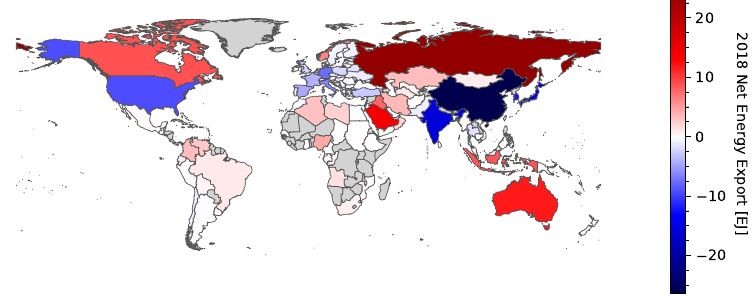
Figure 2. The map of net energy export of fossil fuels in 2018 based on UNCT database.